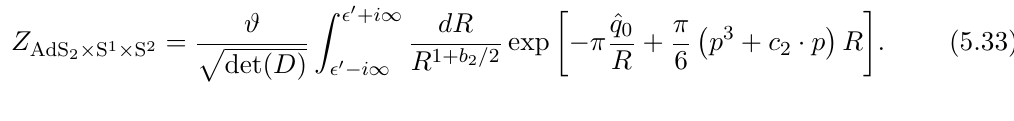
Figure 2 . Contour deformation for the integral R dz e az + b=z semicircle contour of radius (cid:15) and C R is the original contour. It is easy to show that the